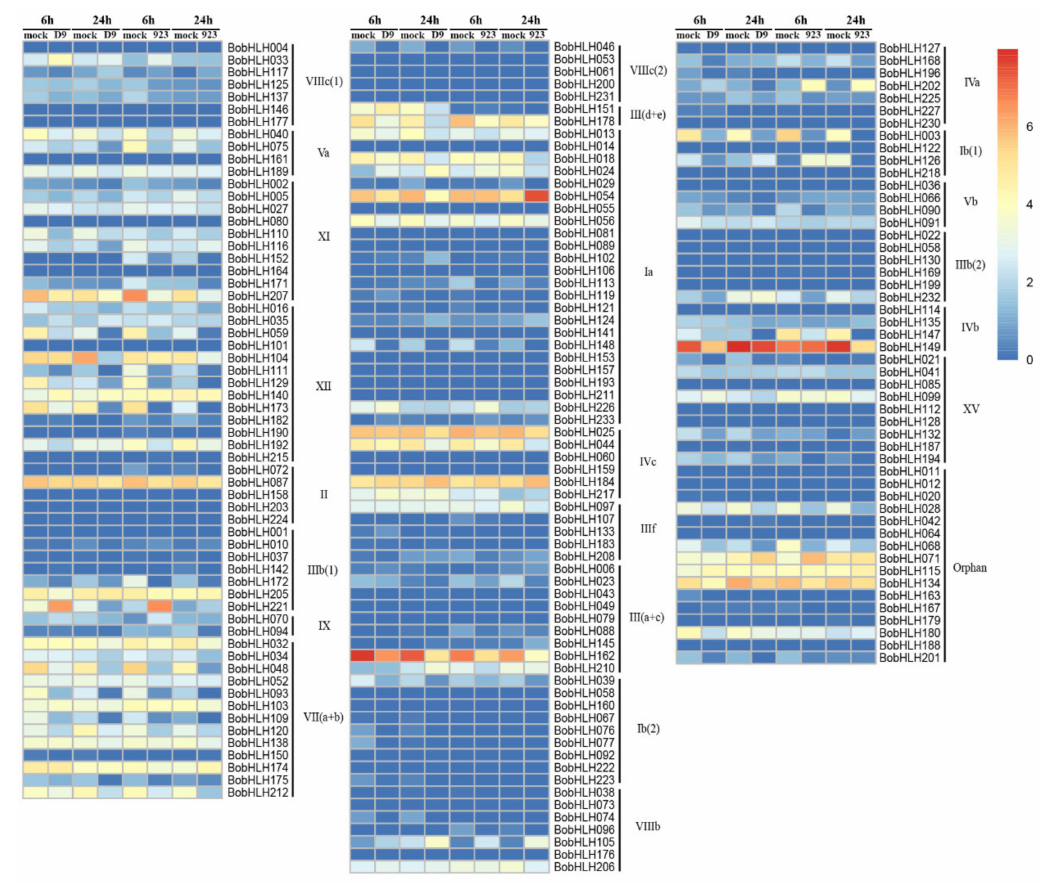
Figure 4. Expression profiles of BobHLH genes under chilling